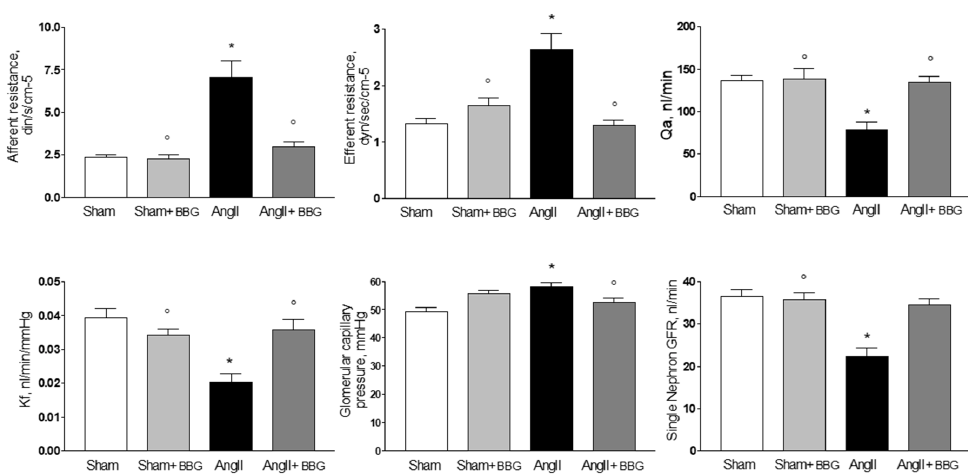
Figure 2. Glomerular hemodynamics in Sham, Sham + BBG, Ang II and Ang II + BBG groups ( n = 8 rats / group). * p < 0.001 vs. Sham; p < 0.001 vs. Ang II. Qa = glomerular plasma flow; Kf = ultrafiltration coefficient; GFR = glomerular filtration rate, Ang II = angiotensin II, BBG = brilliant blue G.